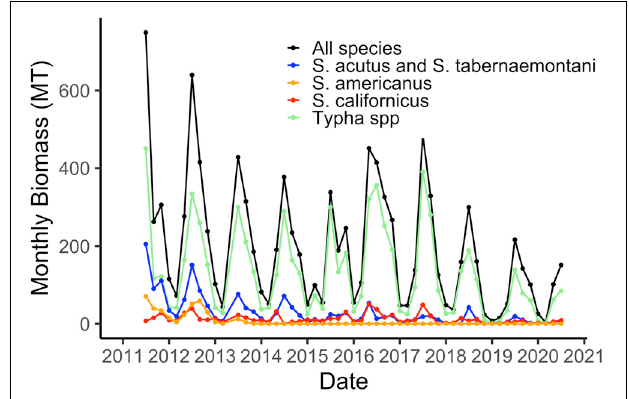
FIGURE 2 | Total aboveground live plant biomass in the 21 ha marsh system for all species combined and for the four species groups defined by the phenometric models (Weller et al.,